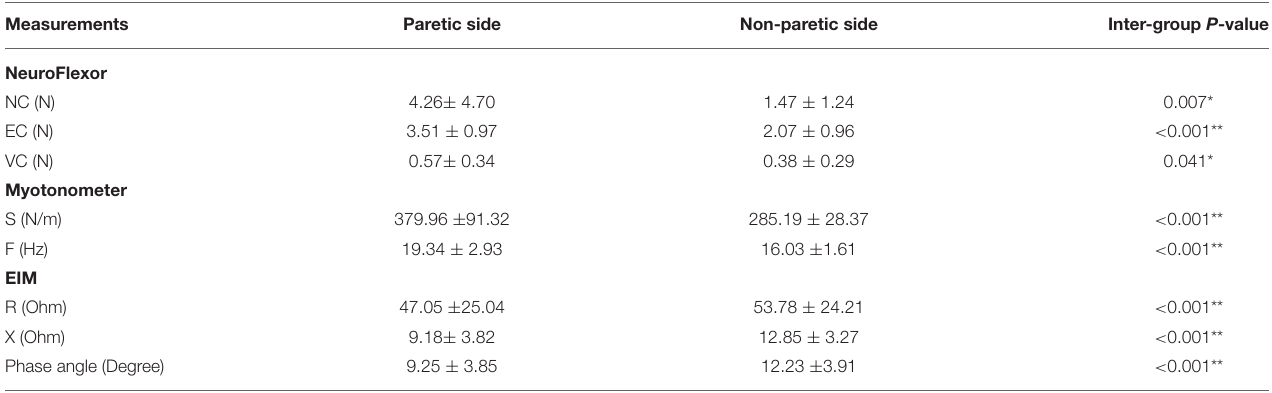
TABLE 2 | Summary of the NF, Myotonometer and EIM parameters on the paretic and non-paretic side.